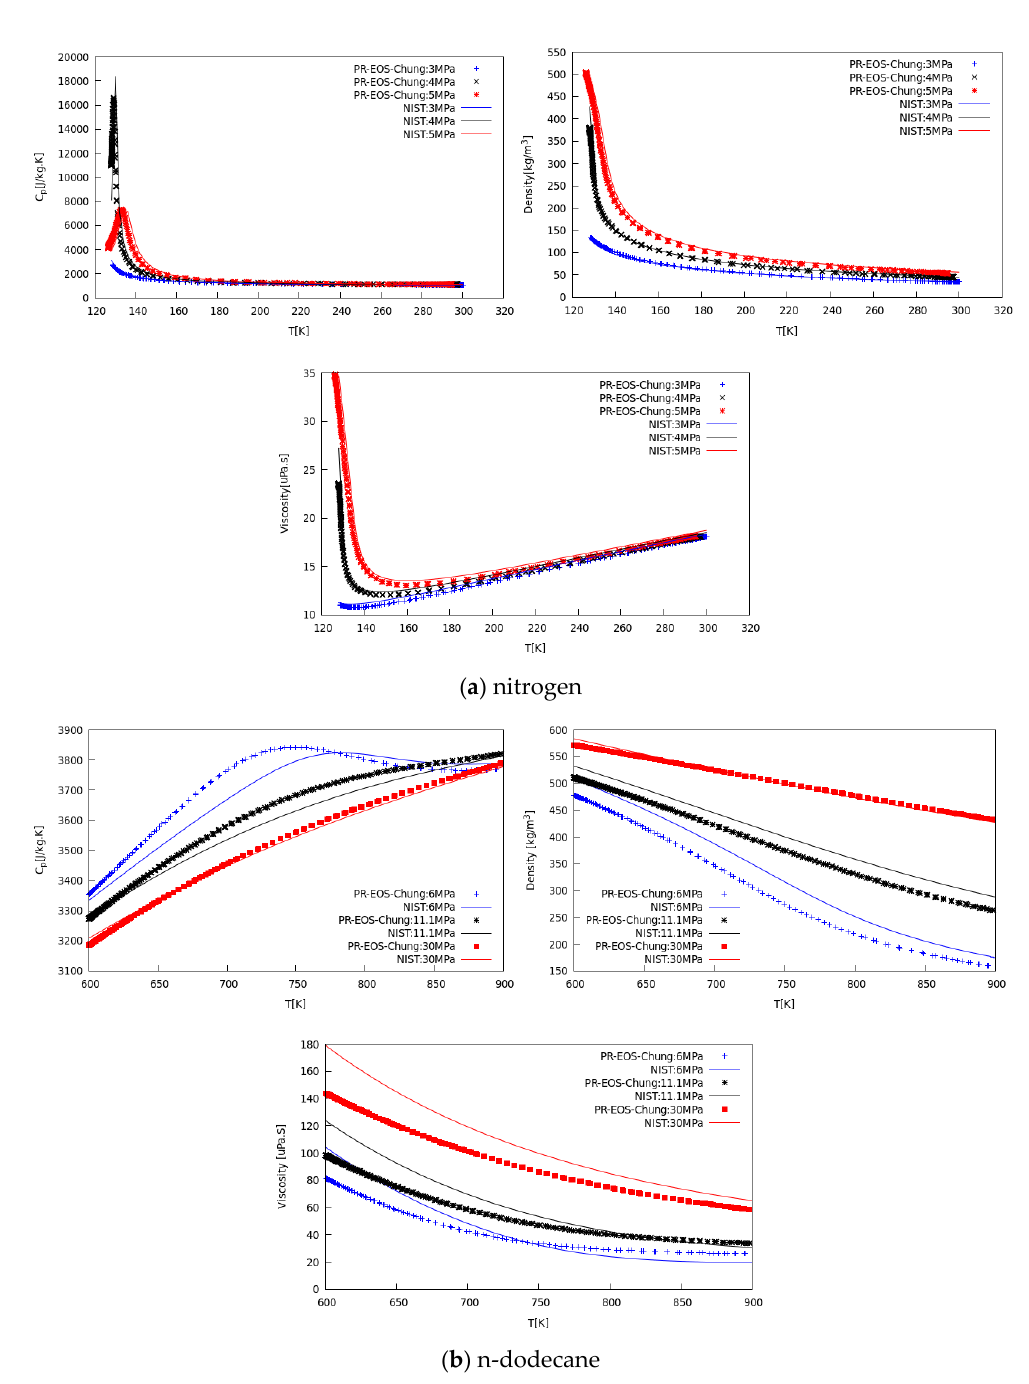
Figure 2. Verification of CFD results (scatter points) against NIST data (line) vs. temperature for specific heat at constant pressure, density, and dynamic viscosity of ( a ) nitrogen at 3, 4, and 5 MPa, and ( b ) n-dodecane at 6, 11.1, and 30 MPa.